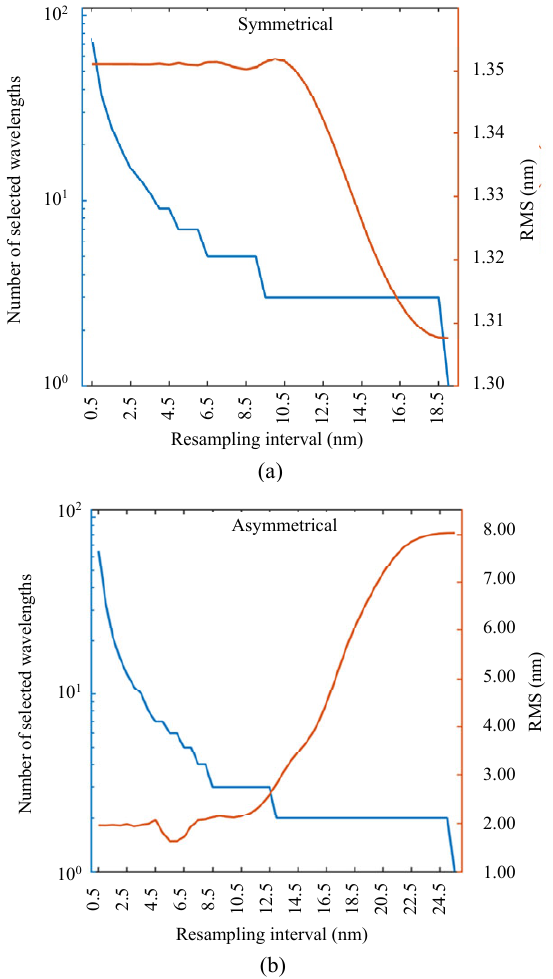
Fig. 11 Number of selected wavelengths and RMS plots of wavefront errors varying with sampling interval of MWCW method for (a) symmetrical and (b) asymmetrical S ( 